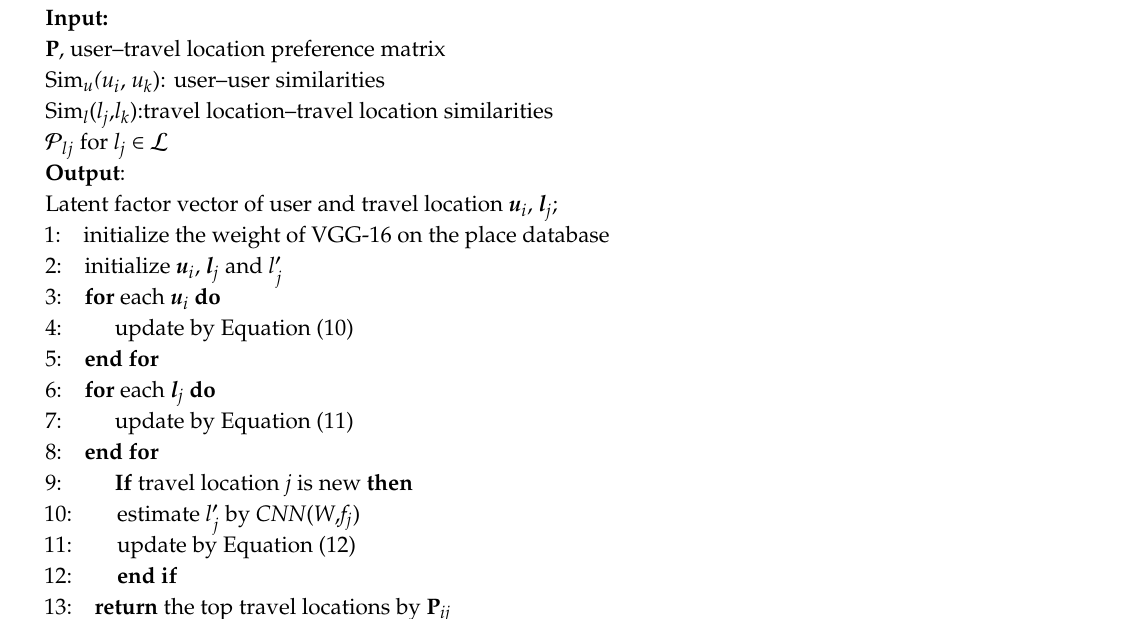
Algorithm 1. The proposed Framework